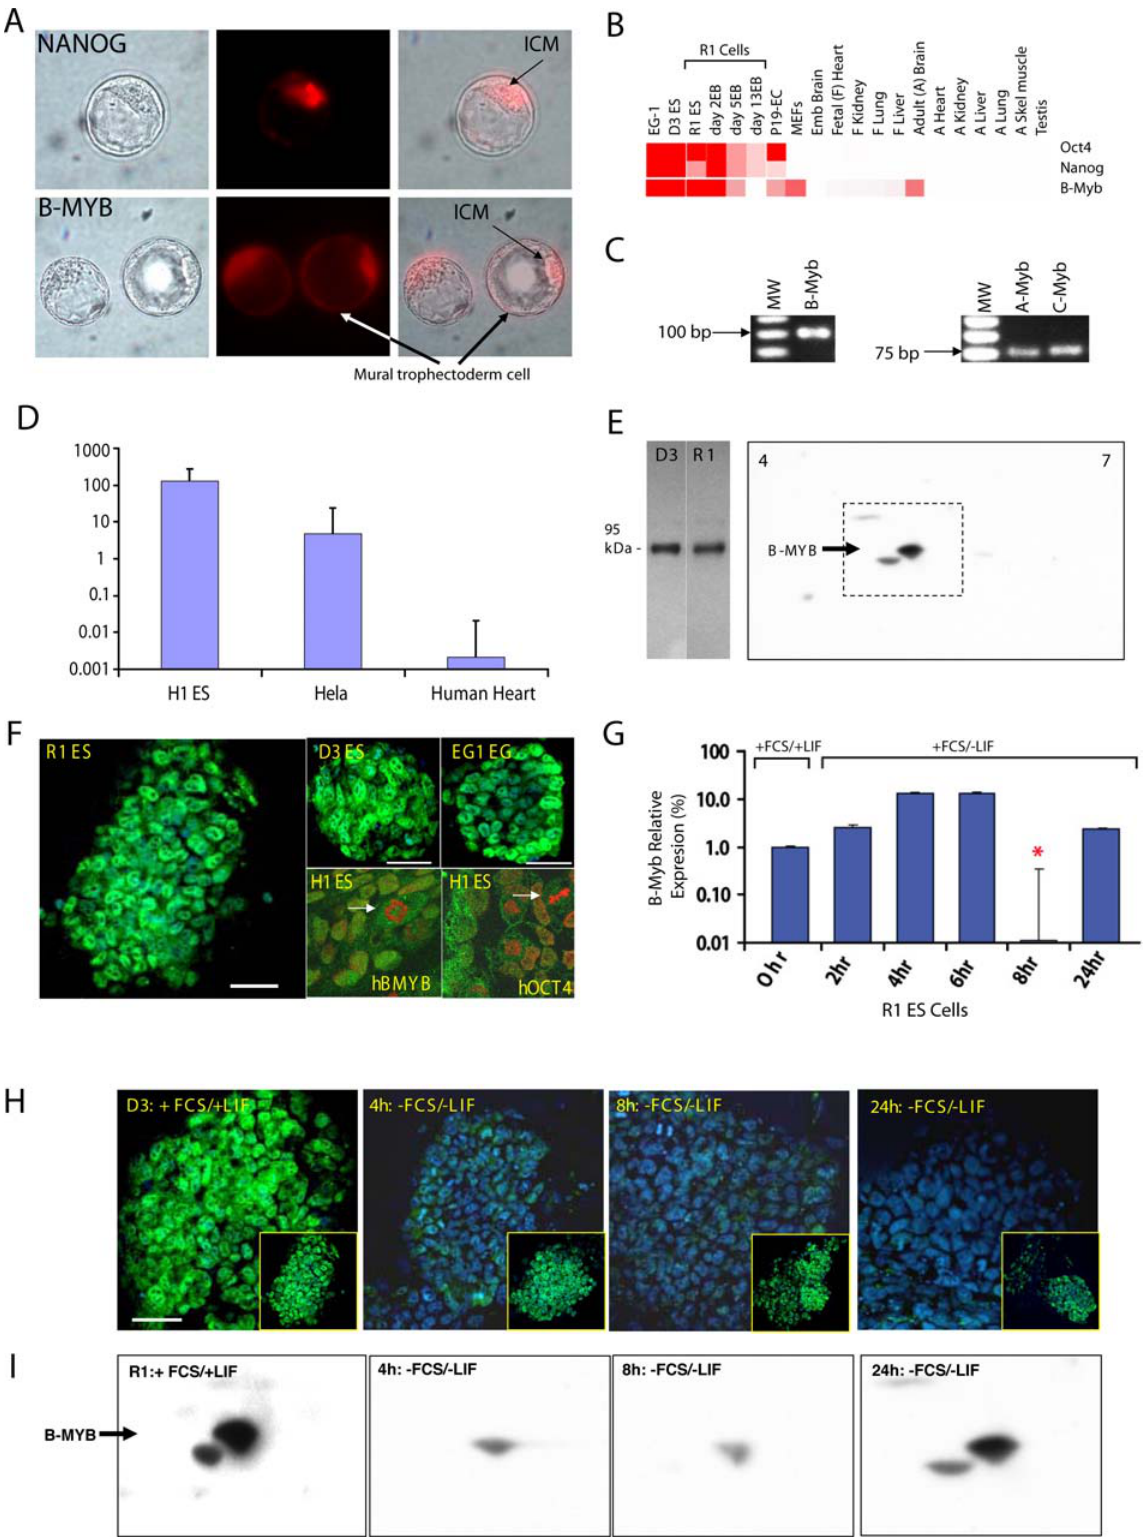
Figure 1. Mybl2 gene products are abundant in pluripotent stem cells and are dynamically regulated during differentiation. A) Representative immunostainings of pre-implantation mouse blastocysts. Immunostaining of B-MYB proteins was observed not only in the inner cell mass (ICM) but also in the mural trophectoderm. Antibodies to NANOG were used to specifically mark cells of the ICM [42]. B) Summary qRT-PCR data showing the relative abundance of B-Myb mRNA among cells and tissues. Data are expressed in heat map form, where color intensity (red) indicates the relative abundance of B-Myb transcripts. Although relatively high expression is seen in proliferating MEFs and adult brain, transcripts are more